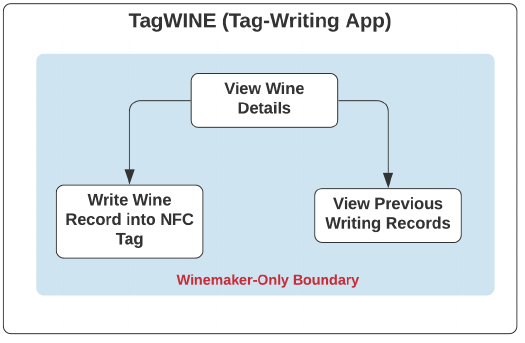
Figure 5. Use Case of Tag-Writing App-TagWINE.